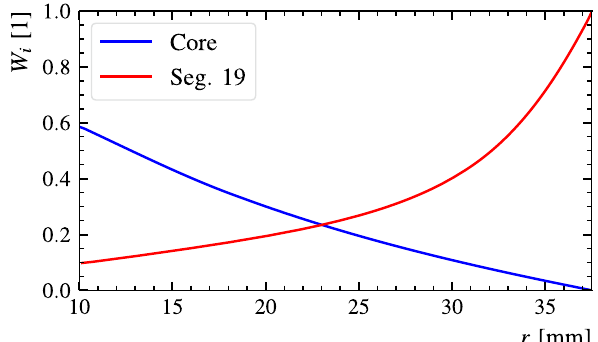
Fig. 21 Weighting potentials of the core and segment 19 along r at the top surface of the detector at ϕ = 135 . 6 ◦ (fast axis) and z = 70mm as calculated with SSD